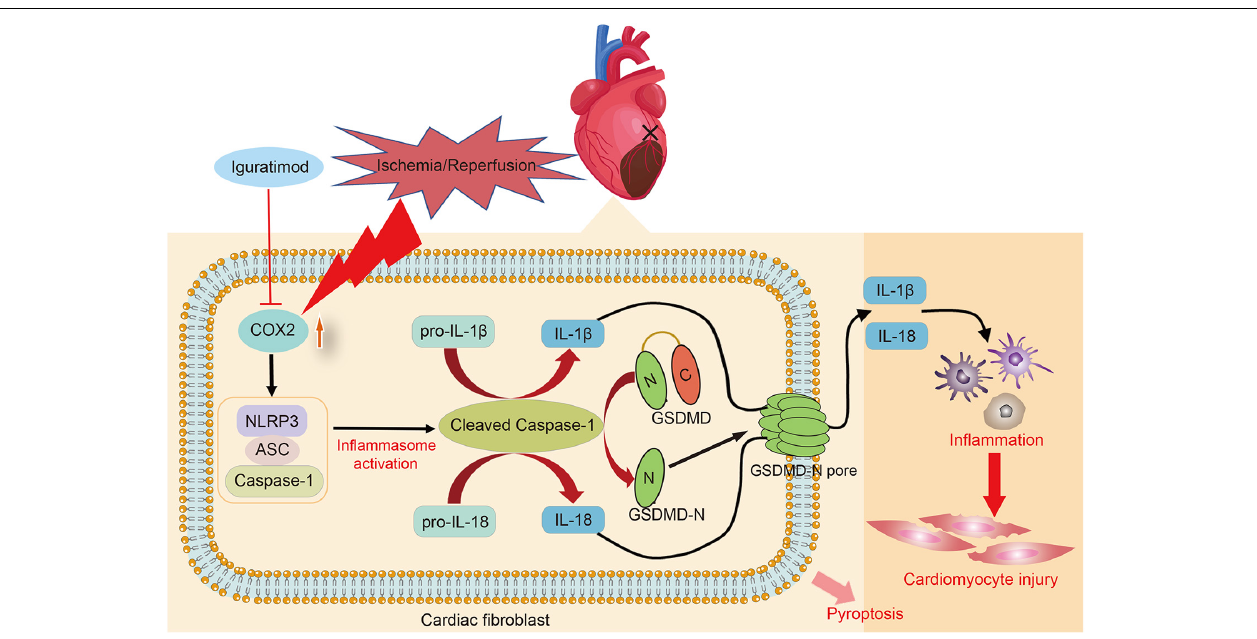
FIGURE 8 | Schematic diagram of this study: the primary mechanism of Iguratimod pretreatment ameliorating myocardial ischemia/reperfusion injury. Specifically, the expression of COX2 in cardiac fibroblasts was elevated after cardiac I/R, leading to the upregulation and activation of NLRP3 inflammasome. Activated caspase-1 cut GSDMD into GSDMD-N, which further executed pyroptosis. Additionally, pro-IL-1 β and pro-IL-18 were also cleaved by activated caspase-1 and subsequently their mature forms were released into extracellular region and triggered amounts of inflammatory cells infiltration in the cardiac tissue, causing inflammatory reperfusion injury. Iguratimod reduced inflammatory cytokines secretion and cardiac inflammation response through inhibiting pyroptosis of cardiac fibroblasts via acting on COX2/NLRP3 signaling pathway, eventually improving myocardial I/R injury. I/R,